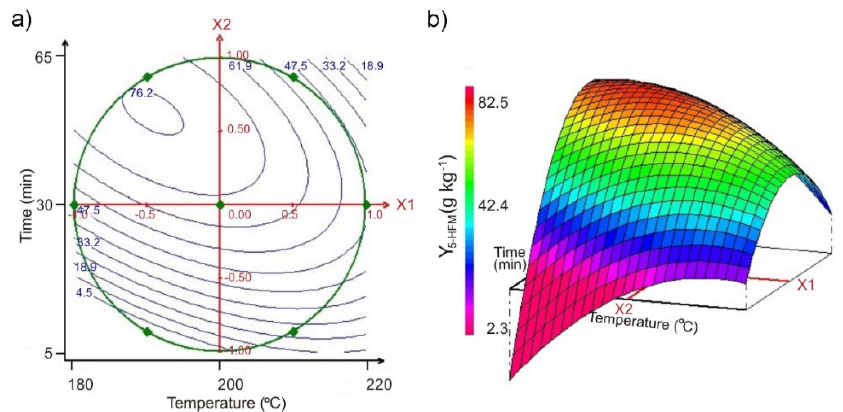
Figure 2. Two- ( a ) and three-dimensional ( b ) illustrations of the model for the yield of 5-HMF in the WS fractions presented as a temperature and holding time function in the course of the PF-SBP hydrothermal treatment.